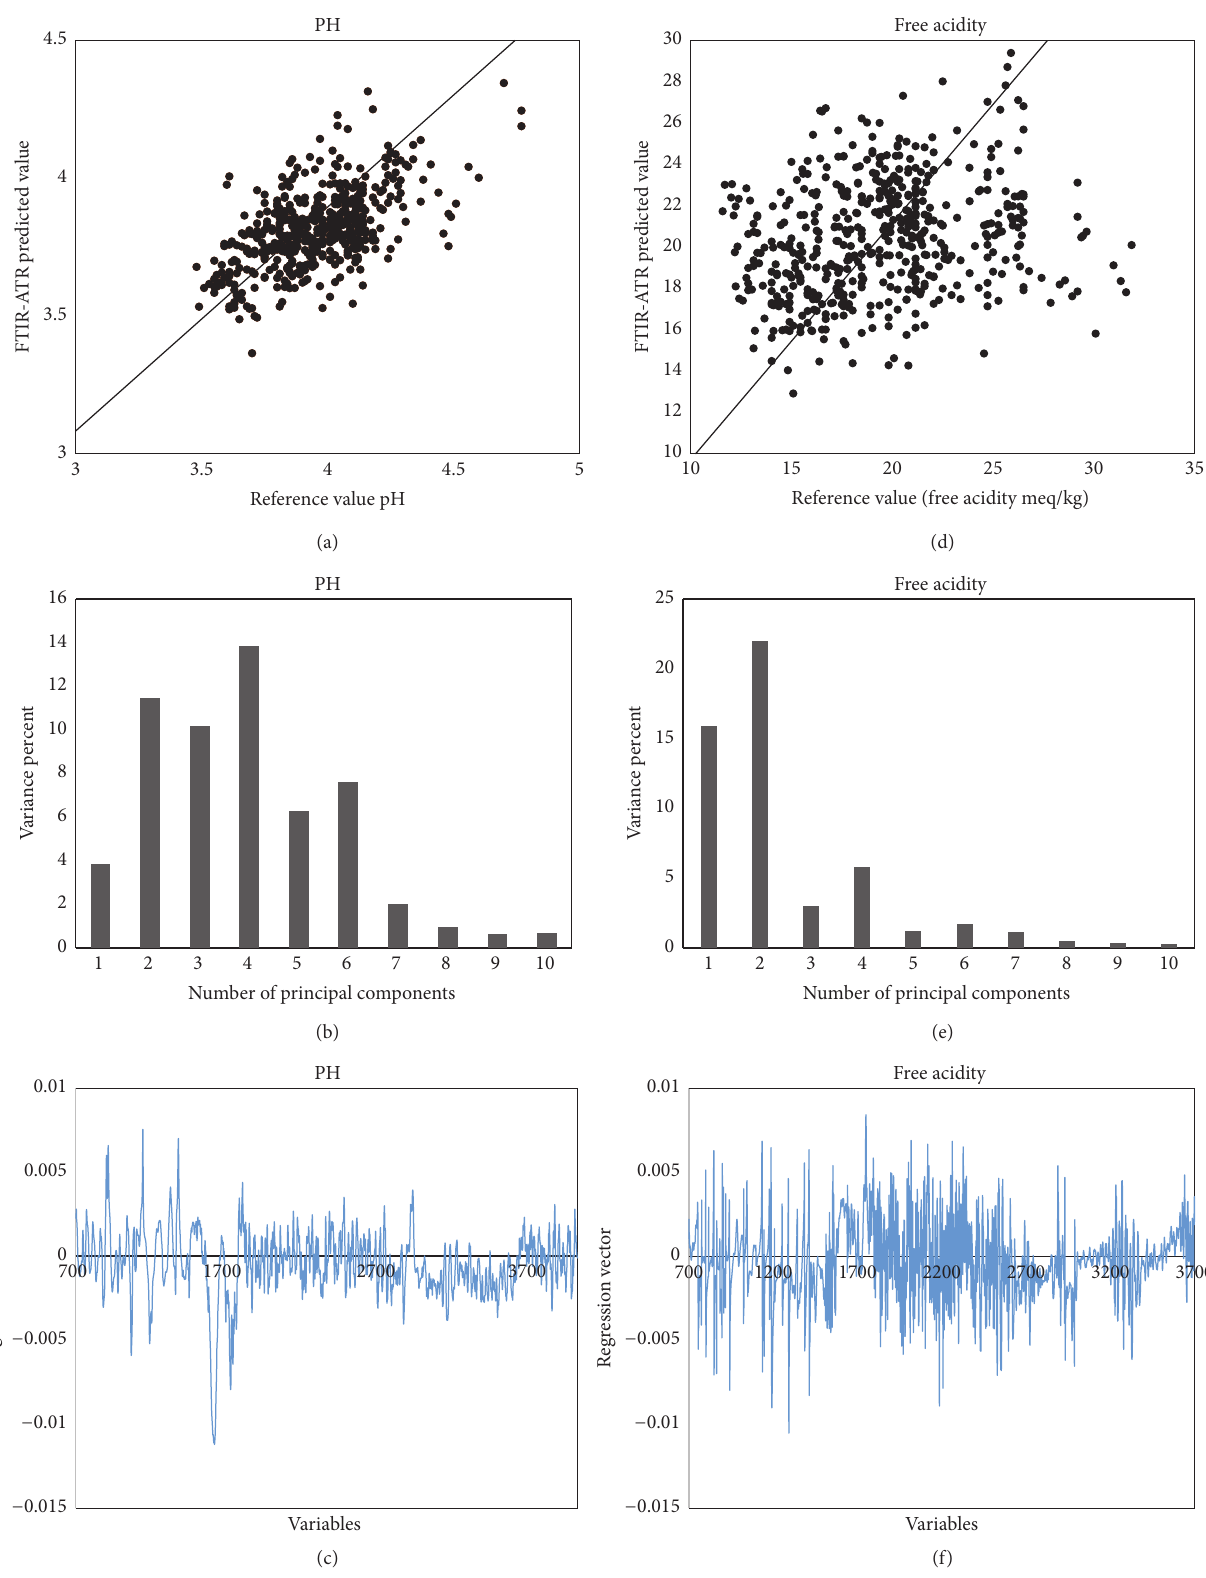
Figure 3: PLS validation plots of pH, contribution of PCA, and regression vector (a)–(c); PLS validation plots of free acidity, contribution of PCA, and regression vector